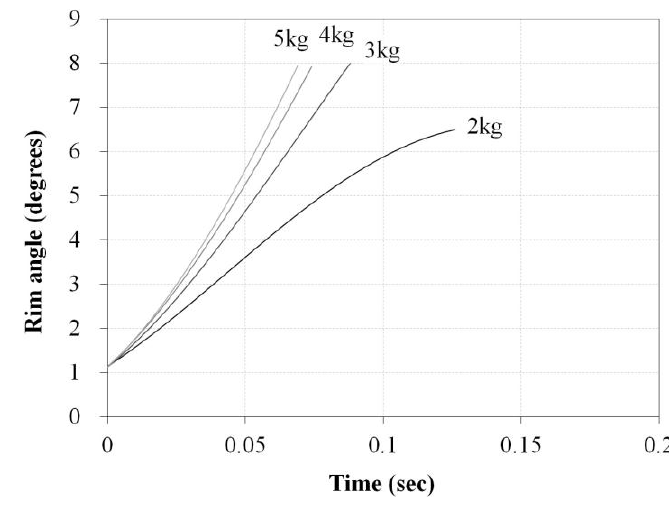
Figure 4. Simulation results for bar angle with extension springs for 2~5 kg dropping weights.